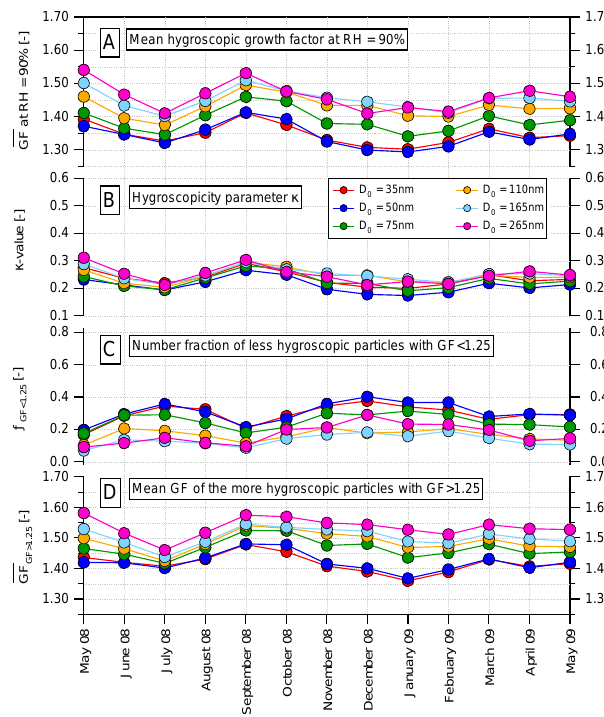
Fig. 3. Annual cycles (A) of the mean hygroscopic growth factor (GF) at 90% RH, (B) of the corresponding hygroscopicity parame- ter κ , (C) of the number fraction of less hygroscopic particles with GF < 1.25, f GF < 1 . 25 , and (D) of the mean GF of the more hygro- scopic particles with GF > 1.25, GF GF > 1 . 25